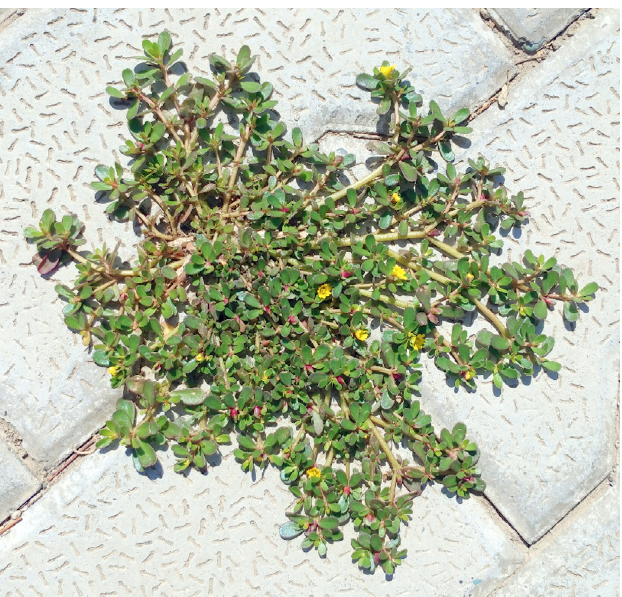
Fig. 1: Purslane is a hardy species with capability to grow in hot and dry environmental conditions. This picture indicates how the plant can survive abiotic challenges such as drought and poor soil. The fleshy nutritious leaves of the plant have decent salty/sour taste. These specifications make it a potential vegetable crop for the